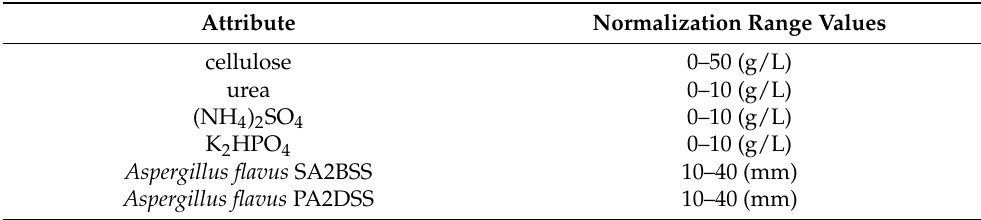
Table 1. Normalization ranges of attributes in ANN modelling. All of these ranges were scaled to the range [0,